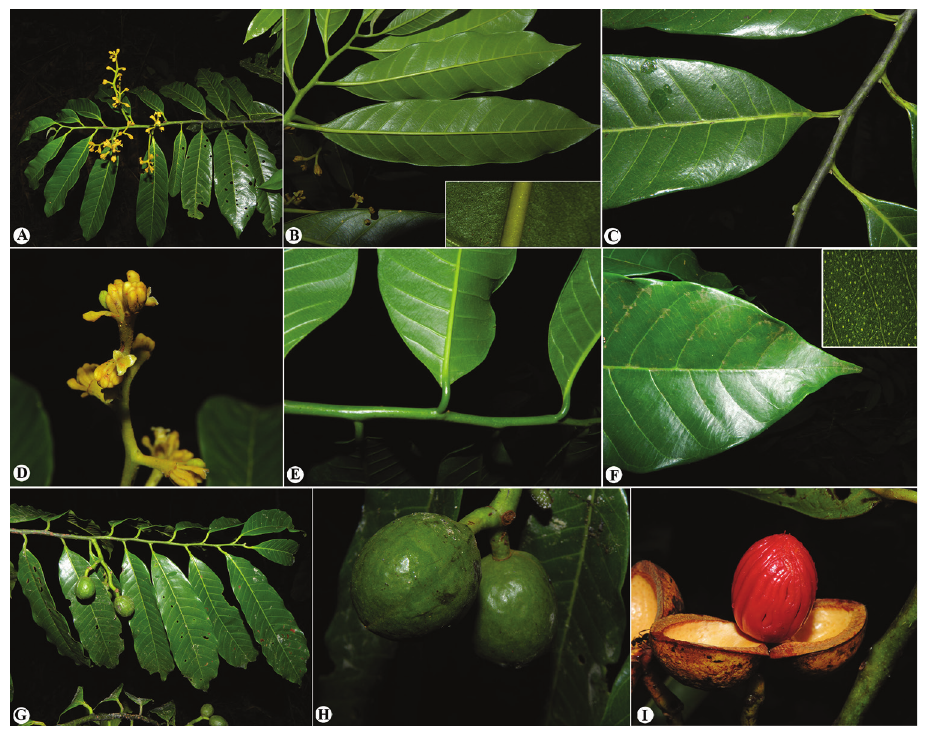
Figure 19. Virola laevigata A branch with staminate inflorescences B leaf blades on abaxial surface, inset showing the glabrous midvein C twig, petiole and leaf on adaxial surface D close up of staminate inflores- cences E leaf base F leaf apex, inset showing leaf punctations G branch with immature fruits H close-up of immature fruit I open fruit, showing the aril. Photos by Reinaldo